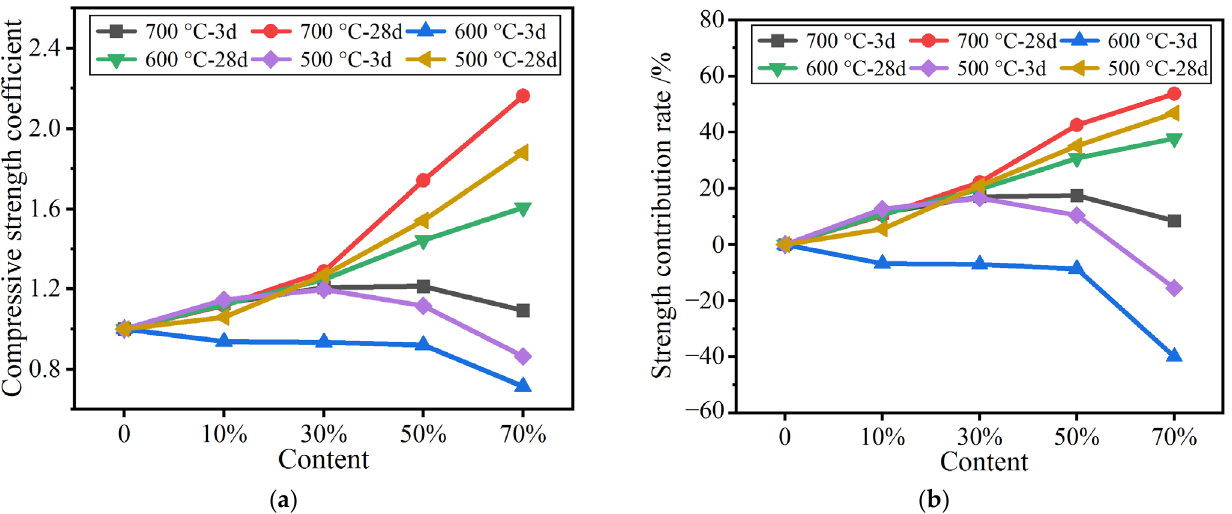
Figure 6. ( a ) Specific compressive strength coefficient for mortar with calcium - added gangue ( b ) Strength contribution rate of mortar with calcium - added gangue.